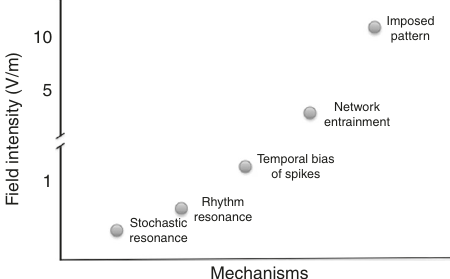
Fig. 2 Five postulated mechanisms to affect online spiking of neurons and networks patterns in response to different estimated magnitudes of TES. current data and theoretical